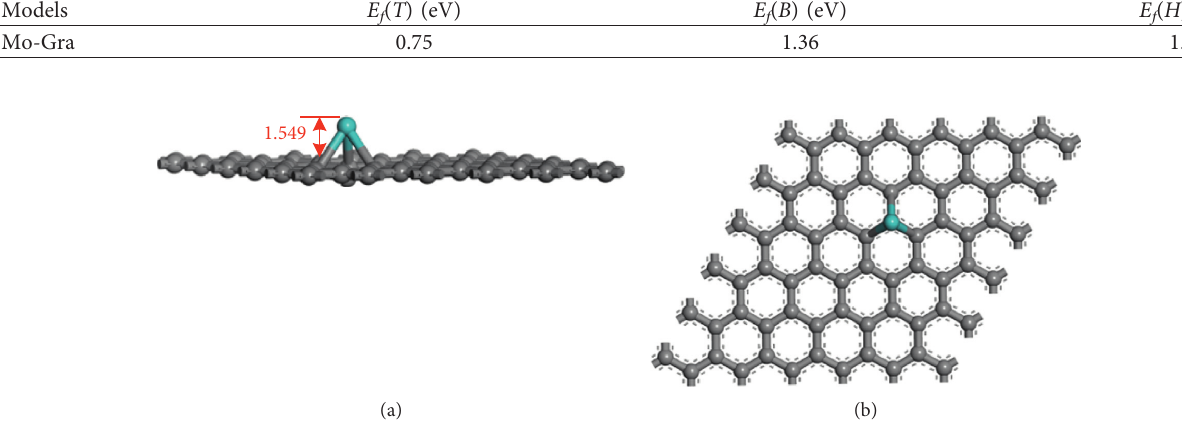
Figure 3: Mo doping site: (a) Side view and (b) top